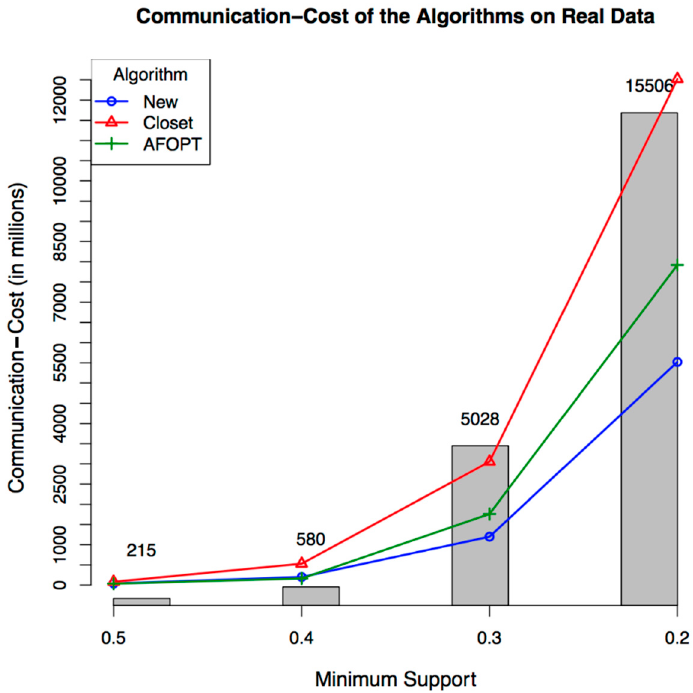
Figure 6. Communication–cost of the algorithms on real data.